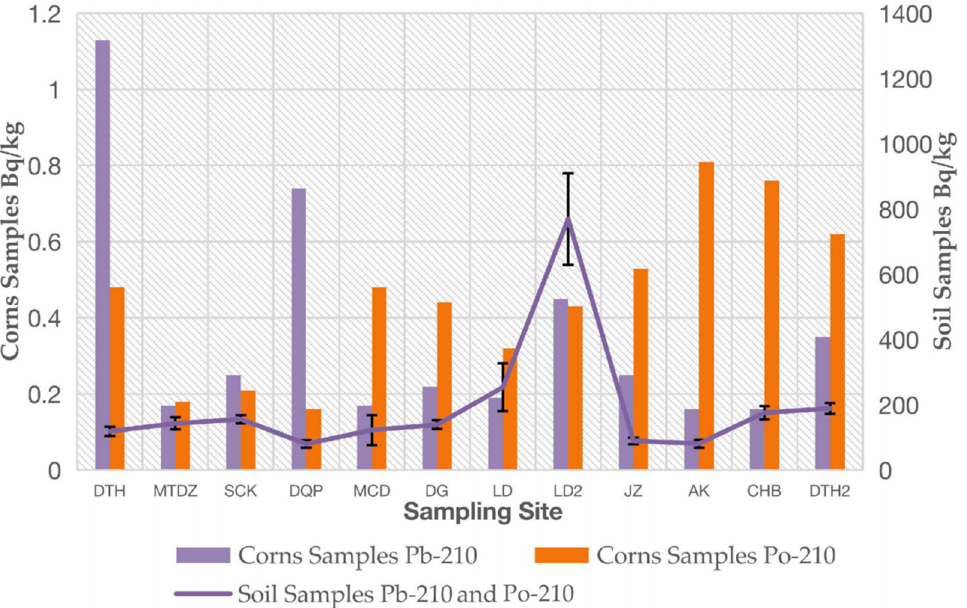
Figure 3. The activity concentrations of 210 Pb and 210 Po in corn samples and their corresponding farmland soil samples.